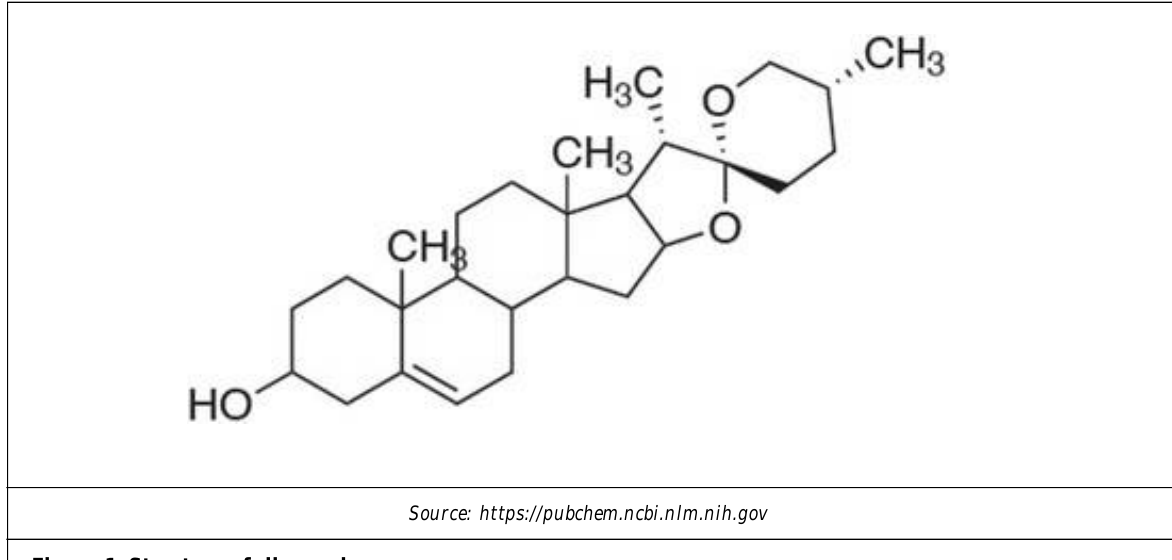
Source: https://pubchem.ncbi.nlm.nih.gov